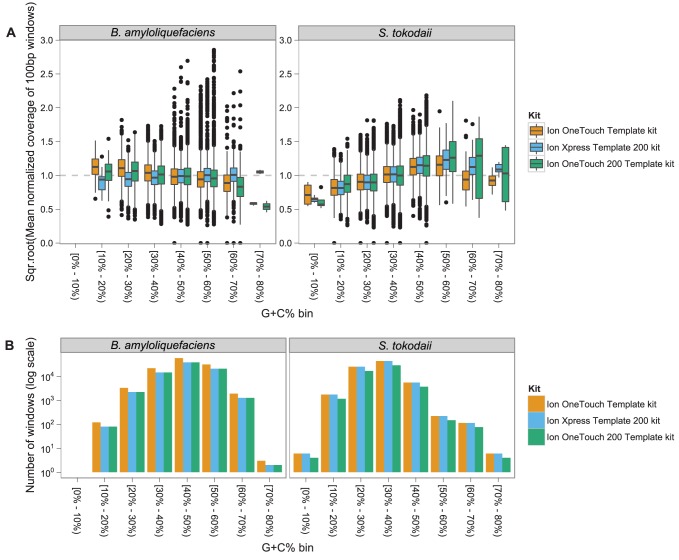
Relationship between G+C% and the observed mean coverage for 100 bp bins in the reference genome.Panel (a) is a boxplot of the distribution of the square-root normalized mean read depth across the 100 bp windows for each reference genome, broken down further by sequencing kit and G+C% bin. The coverage for each run was normalised by the mean coverage –the boxplots show the square-root fold-change from the mean genomic coverage for each combination of species, kit and G+C% bin. Thus a value of 2 means the coverage was four times that of the mean for that sequencing run. The boxes display the central 50% of the values in each treatment, with the median represented by the solid black horizontal bar. The whiskers each extend for 1.5× the inter-quartile range, and the black dots represent extreme individual observations which fall outside this range. The variability observed in the high G+C bins are likely due to the small sample size for these G+C regions, shown in panel (b). The outliers are potentially due to repetitive content in the genome that failed to be masked by our perfect match repeat approach.